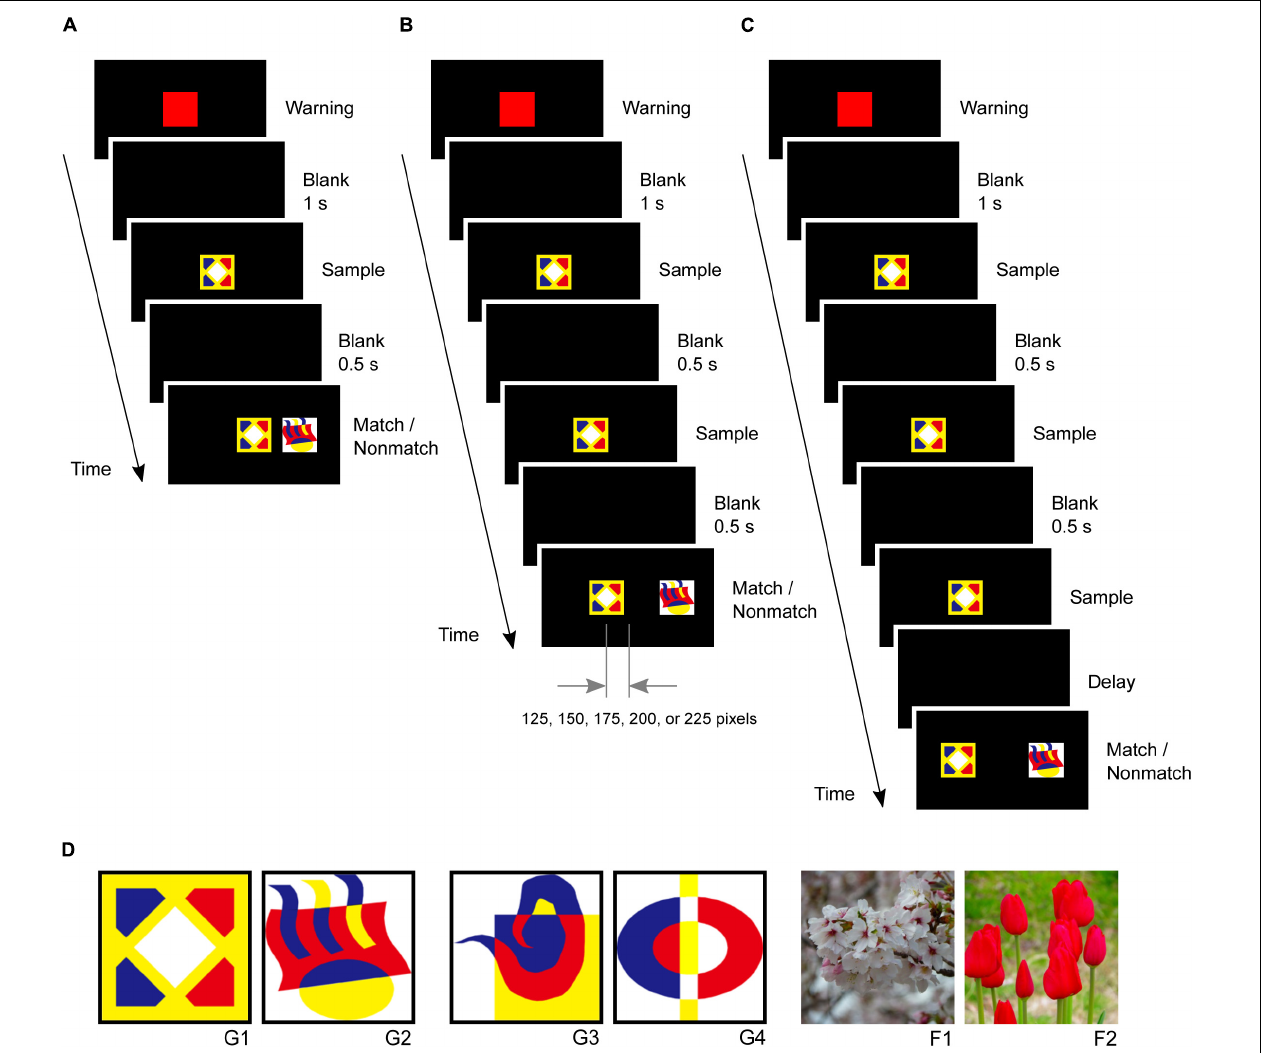
FIGURE 3 | Delayed matching-to-sample task and visual stimuli. (A) After the marmosets touched the sample stimulus, a matching stimulus was presented at the same center position, and a non-matching stimulus was presented 250 pixels right or left of the center. (B) A sample stimulus was presented twice to ensure that the marmosets looked at it. The non-matching stimulus was always located 250 pixels right or left of the center, but the position of matching stimulus gradually shifted 0, 125, 150, 175, 200, 225, and 250 pixels from the center. (C) Task events in a trial of the delayed matching-to-sample task. The same sample stimulus was presented thrice. (D) Visual stimuli used in this study, including four graphic patterns (G1, G2, G3, and G4) and two flower photographs (F1 and